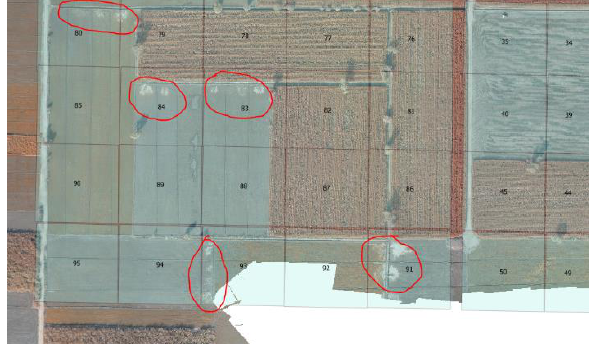
Figure 12. Nitrogen Concentration problem due to flood